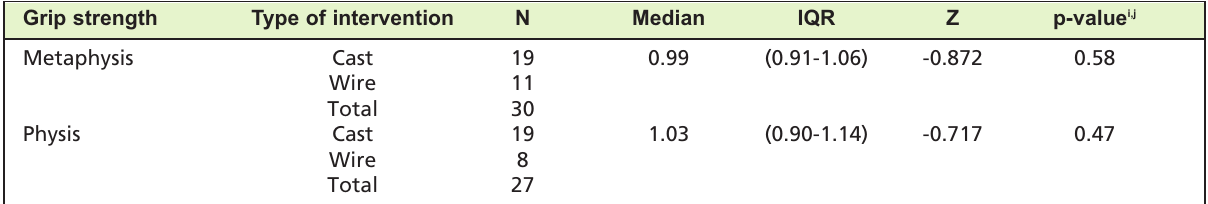
Grip strength at skeletal maturity between cast and wire in metaphysis and physis groups Table VI: